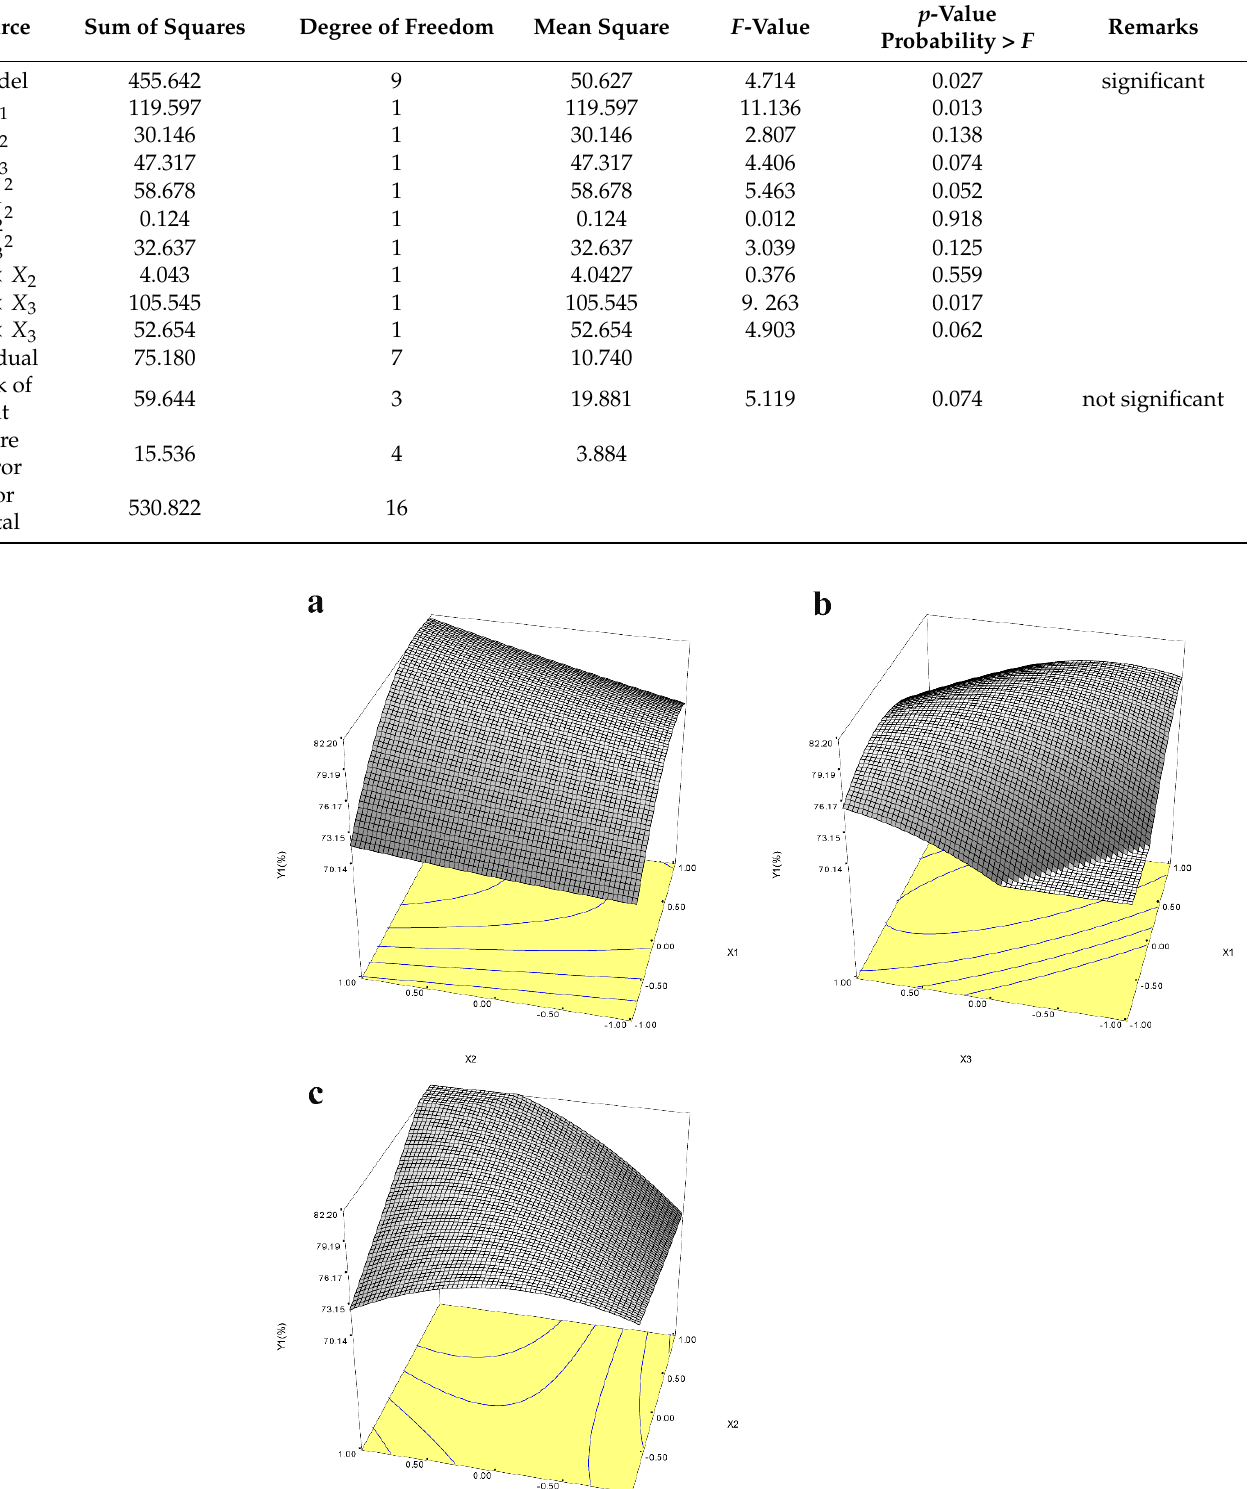
Table 3. ANOVA of the quadratic model for the yield of icariin.